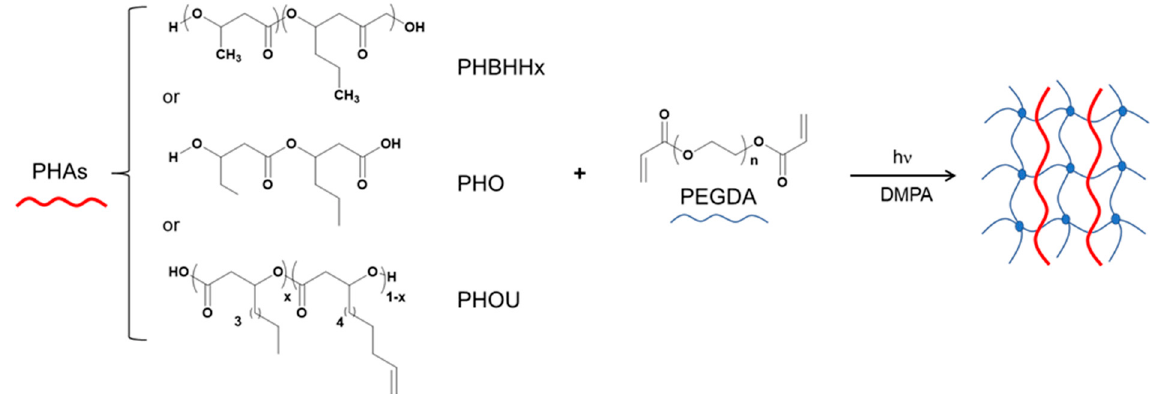
Figure 1. Elaboration of PHA x PEGDA 1 − x networks under photoactivated cross-linking.